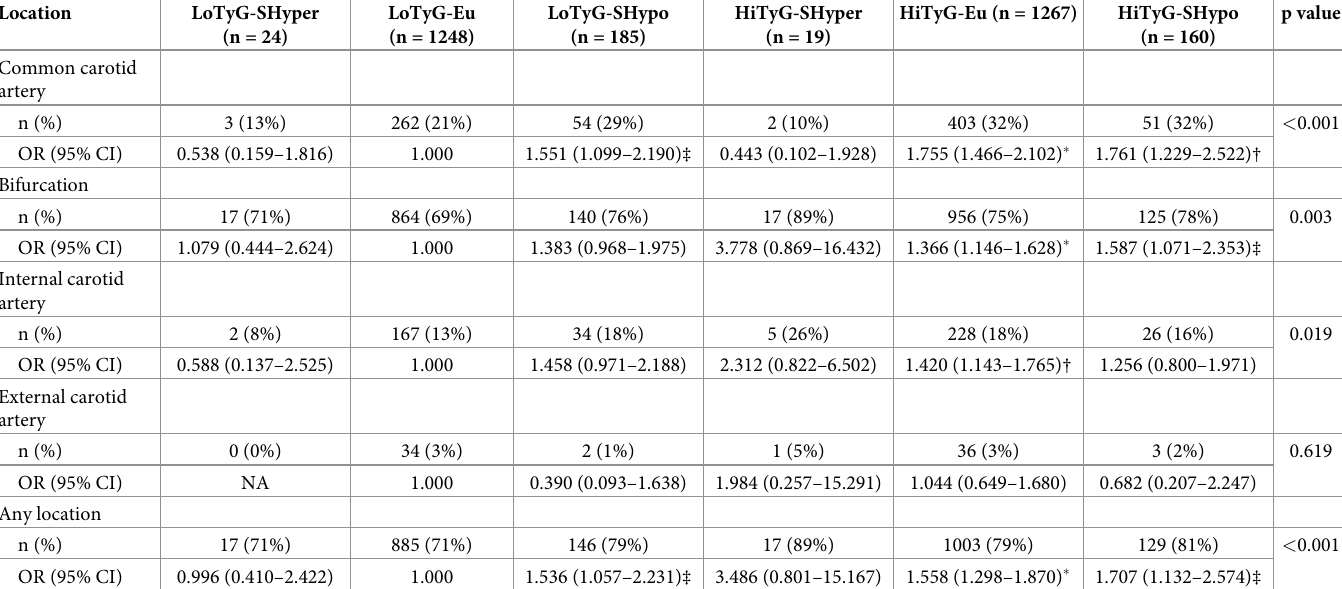
Table 3. Risk of carotid plaques by location according to the triglyceride-glucose index and thyroid function status group.